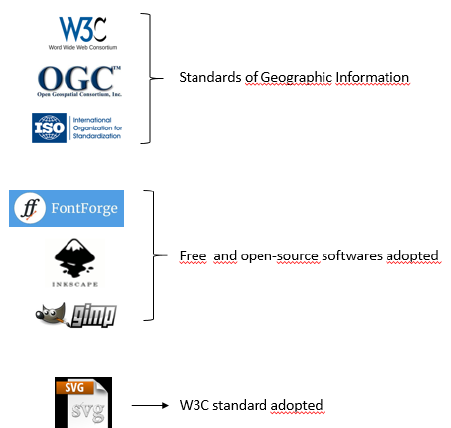
Figure 4 . Standards and open-source technologies adopted.